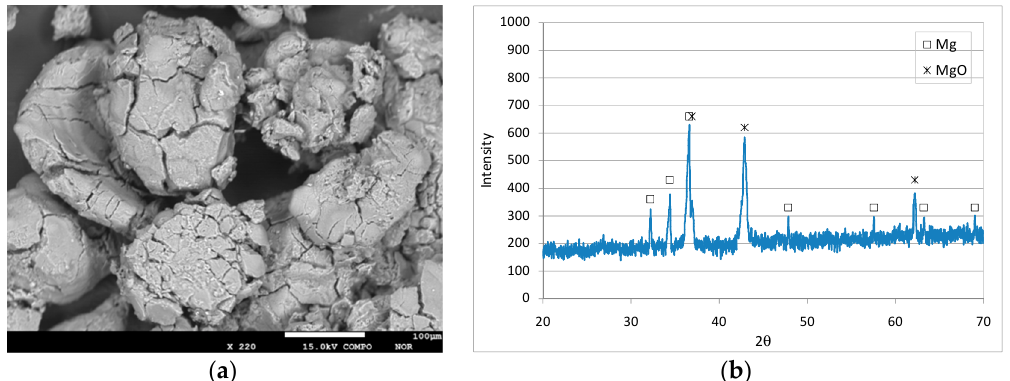
Figure 6. SEM image ( a ) and XRD diffractogram ( b ) of Mg 0 particles after the treatment of the solution with initial N-NO 3 − = 20 mg / L at pH 3.